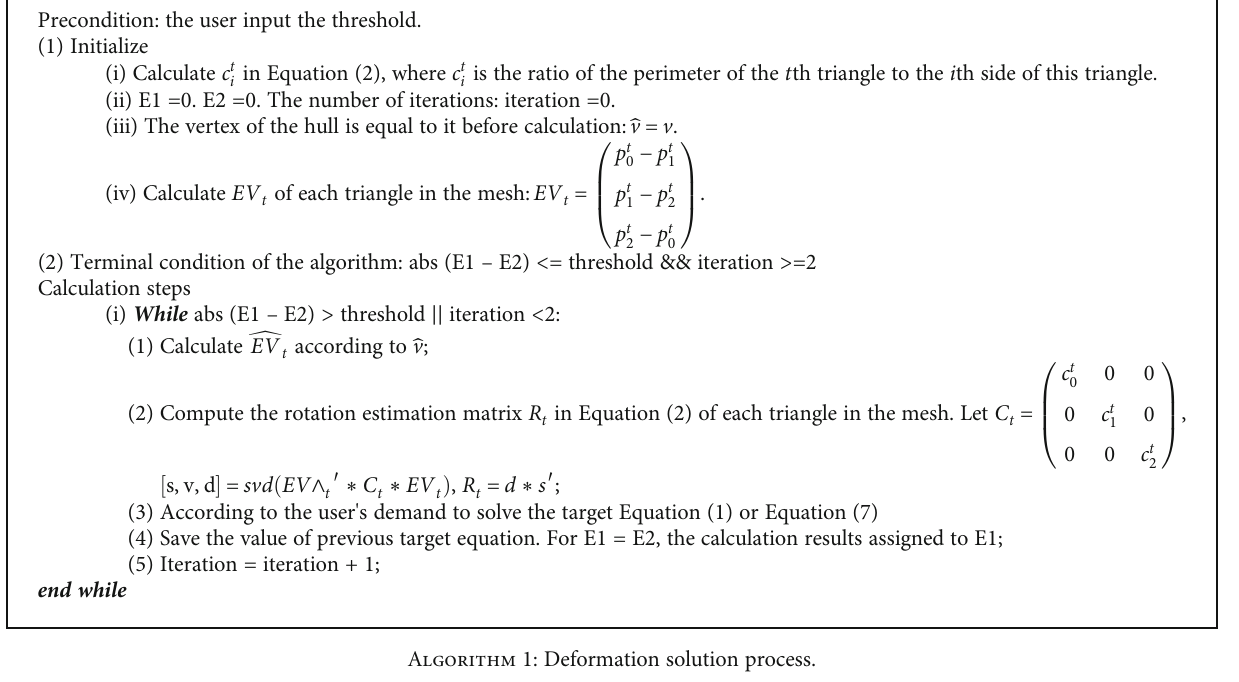
Algorithm 1: Deformation solution process.